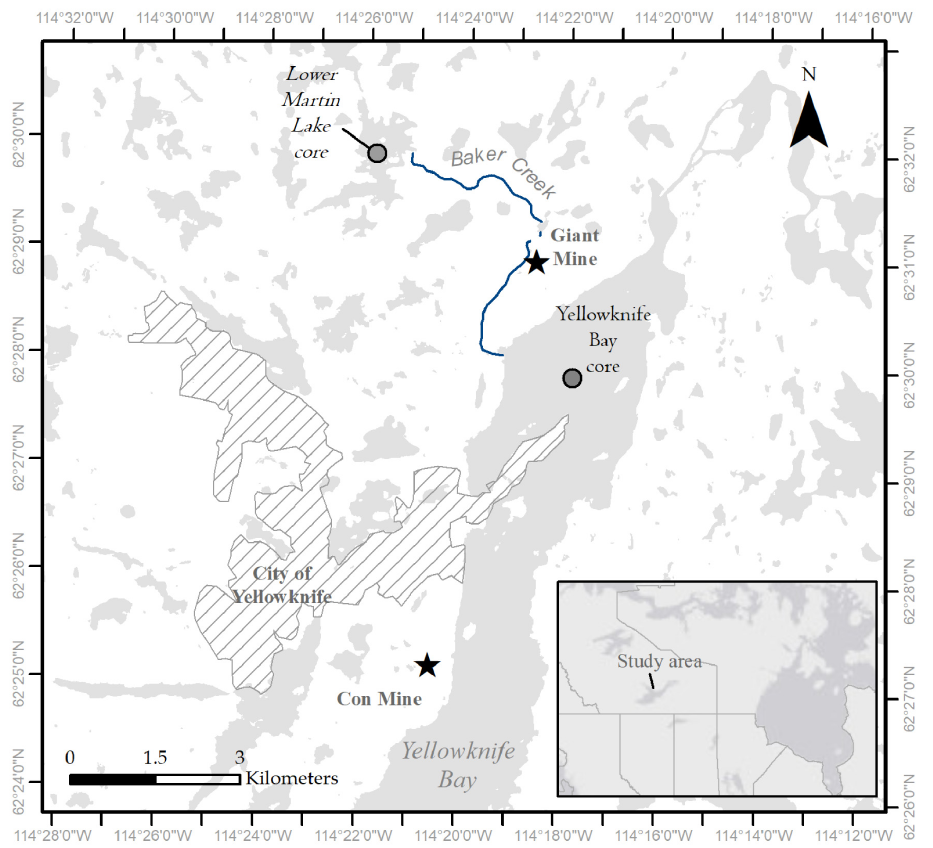
Fig 1. Map of the study area. Approximate locations where the sediment cores were collected from Lower Martin Lake and Yellowknife Bay in relation to the closed Giant Mine and Con Mine, and the capital of the Northwest Territories, Yellowknife, Canada. Spatial data presented in the figure are licensed under an Open Government Licence–Canada from the National Hydro Network (NHN) dataset https://open.canada.ca/data/en/dataset/a4b190fe- e090-4e6d-881e-b87956c07977.